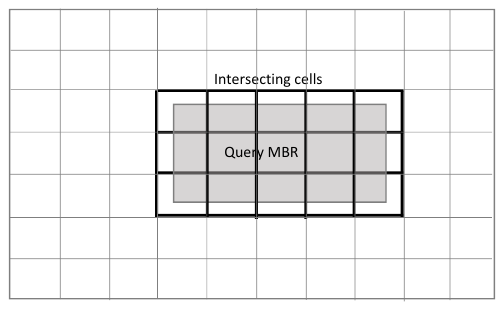
Figure 2. Cells overlapping with MBR.